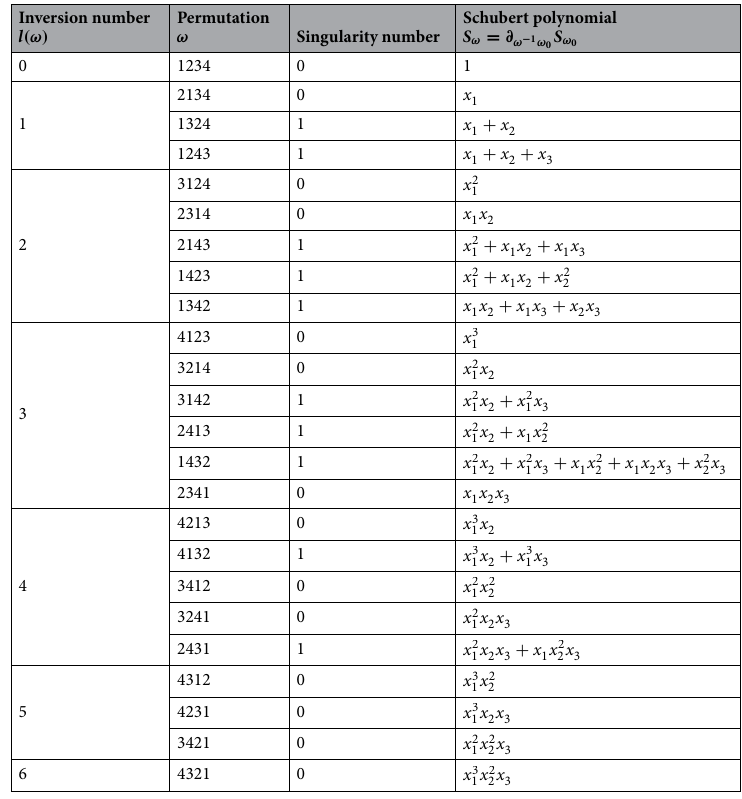
Table 1. Schubert polynomials of S 4 and the corresponding inversion and singularity numbers.